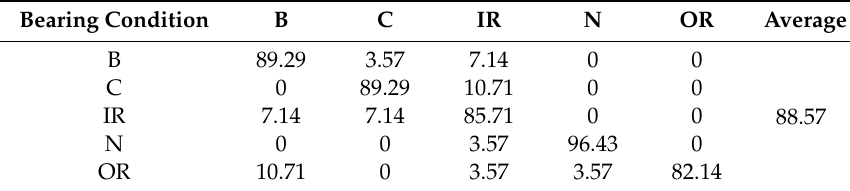
Figure 12. Preliminary diagnosis of support vector machine (SVM). ( a ) Recognition results. ( b ) Absolute error of the proposed approach output with respect to the desired output. Table 8. Classification accuracy of DNN (%). Table 10. Classification accuracy of SVM (%).